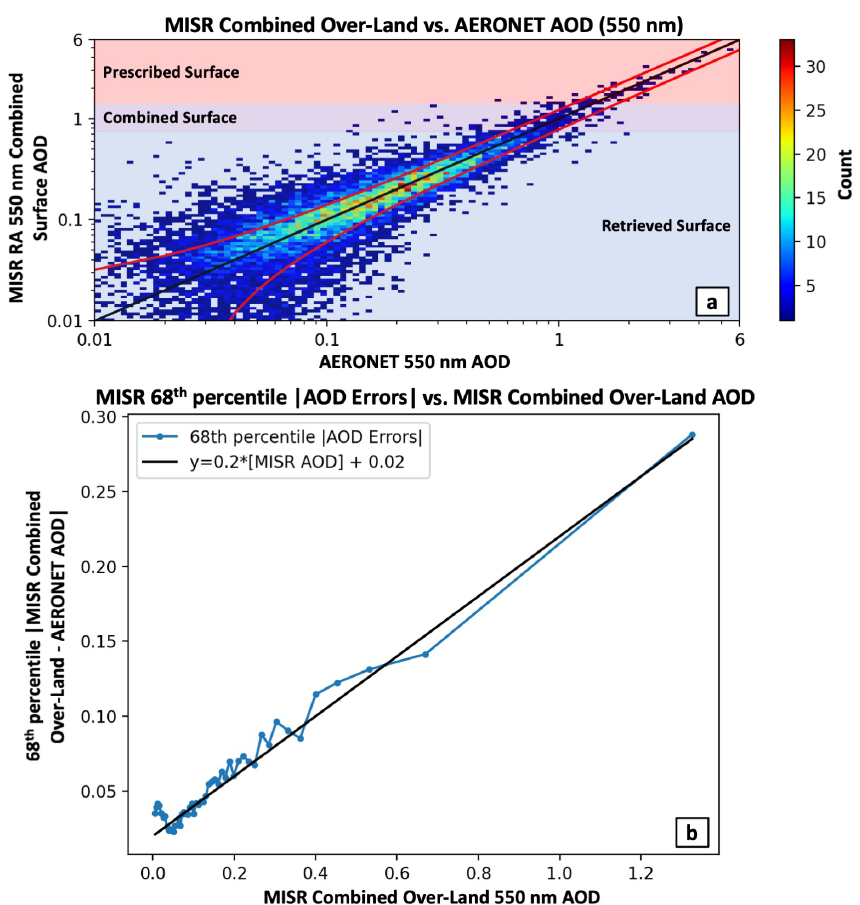
Figure 3. Panel (a) is identical to Fig. 2f, with the addition of a color code added to identify regions where the prescribed and/or retrieved surface algorithms are used in the combined surface algorithm. Panel (b) shows MISR RA 68th percentile absolute AOD errors as a function of MISR combined over-land AOD. Data are plotted at increments of 2% ( ∼ 160 coincidences per data point), with a black expected error line (derived from these data) plotted on top of the data. Table 3. MISR RA vs. AERONET direct-sun over-land statistics. The rows under “AOD comparison” indicate the type of MISR retrieval being compared to AERONET. The rows under “ANG comparison” indicate the MISR RA AOD constraints being placed on the comparison with AERONET (MISR AOD must be > 0 . 05, etc). For the first column, RSA corresponds to the MISR RA over-land retrieved surface algo- rithm, PSA corresponds to the MISR RA over-land prescribed surface algorithm, and CSA corresponds to the MISR RA over-land combined surface algorithm. The number of MISR–AERONET coincidences used to generate a given set of statistics is given in column 2 (No.). Root mean squared error (RMSE) is given in column 3, median absolute error (MAE) is given in column 4, the average MISR–AERONET bias is given in column 5, and the Pearson correlation coefficient ( r ) is given in column